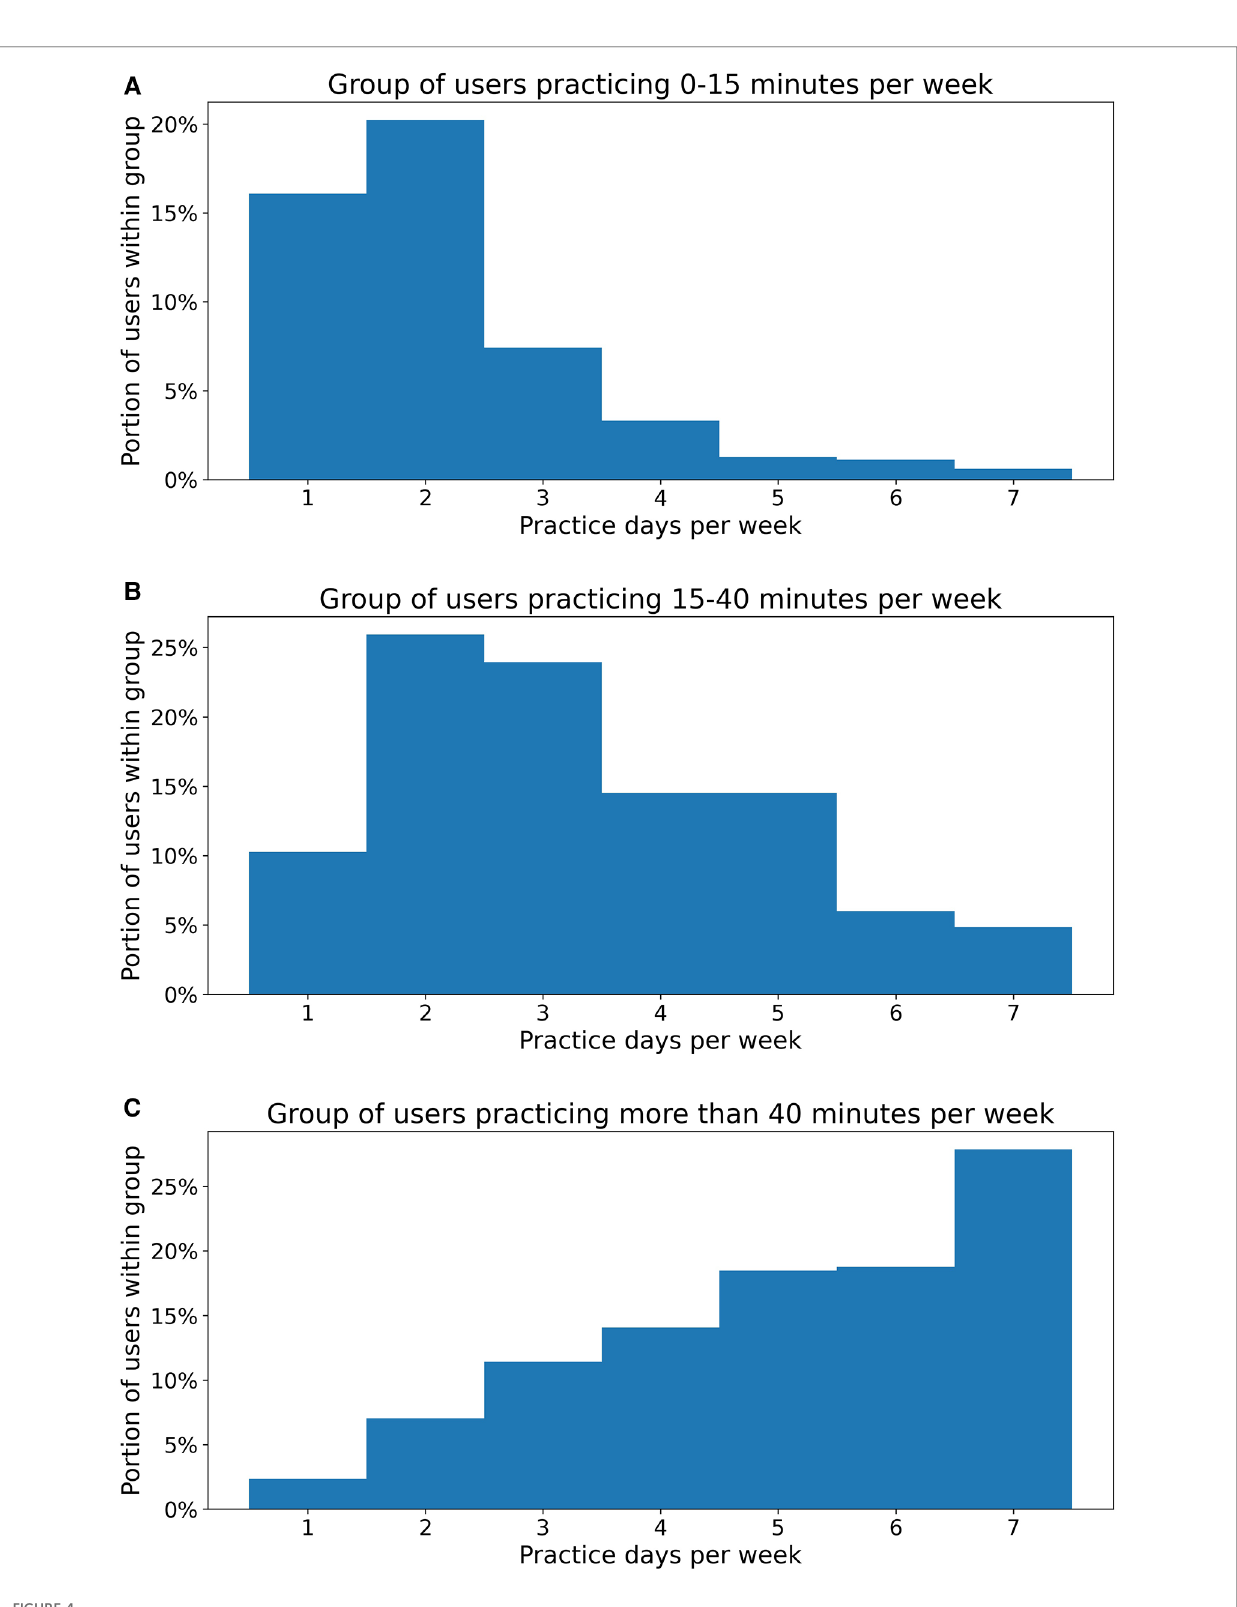
FIGURE 4 Practice frequency distribution of users in different dosage amount